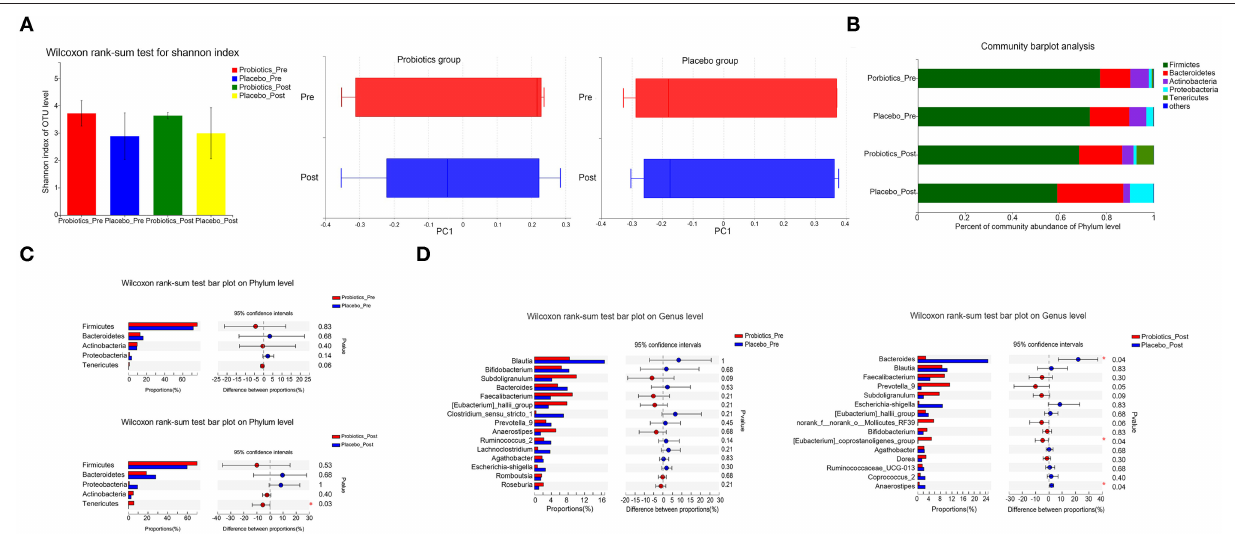
FIGURE 3 | Comparison of the gut microbiota in the probiotics group and the placebo group (a total of 60 samples from 15 patients/group 1 day before the first cycle of docetaxel administration and 21 days after the last cycle of docetaxel administration). (A) α -diversity (Shannon) and β -diversity (PCA) of gut microbiota. (B) The proportion of gut microbiota composition of the patients in the two groups on the Phylum level 1 day before the first cycle of docetaxel administration and 21 days after the last cycle of docetaxel administration. (C) The gut microbial community of the patients in the two groups on the Phylum level 1 day before the first cycle of docetaxel administration and 21 days after the last cycle of docetaxel administration. * P < 0.05. (D) The gut microbial community of the patients in the two groups on the Genus level 1 day before the first cycle of docetaxel administration and 21 days after the last cycle of docetaxel administration. * P < 0.05. The differences between the two groups on the proportion of gut microbiota composition on both the Phylum level and the Genus Level based on Wilcoxon rank-sum